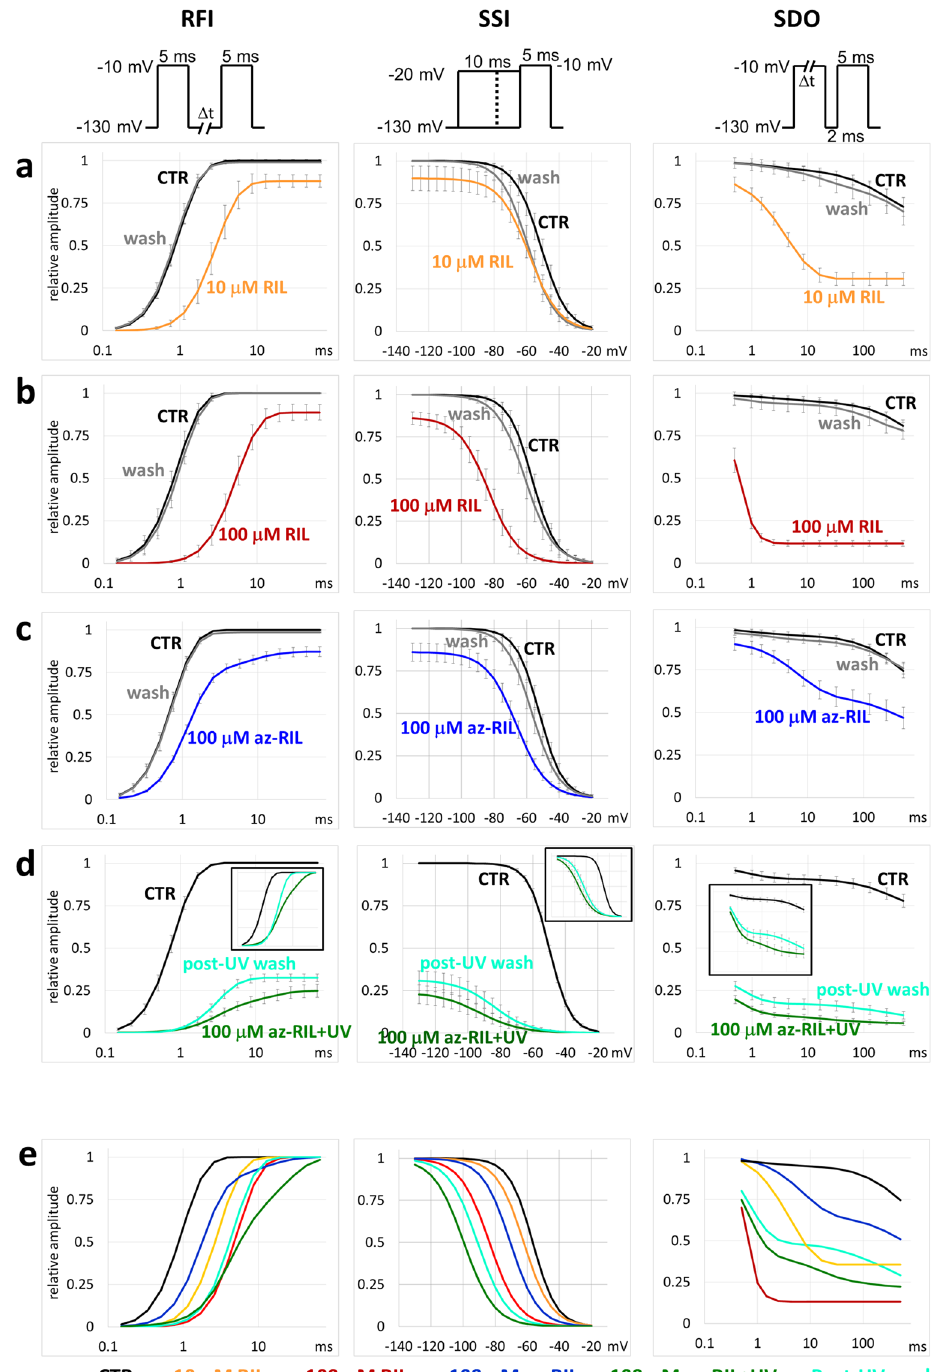
Figure 4. The effect of 10 and 100 µ M riluzole and 100 µ M azido-riluzole in the RFI , SSI and SDO protocols. Black, colored and gray lines indicate control, drug and washout, respectively. ( a ) 10 µ M riluzole. ( b ) 100 µ M riluzole. ( c ) 100 µ M azido-riluzole. ( d ) 100 µ M azido-riluzole during UV-irradiation, and after washout. Turquoise lines indicate washout after azido-riluzole perfusion and UV-irradiation. Insets show curves normalized to their own maxima. Averaging was done as described in Methods. ( e ) Comparison of the effects of all five treatments. All curves were normalized to their own